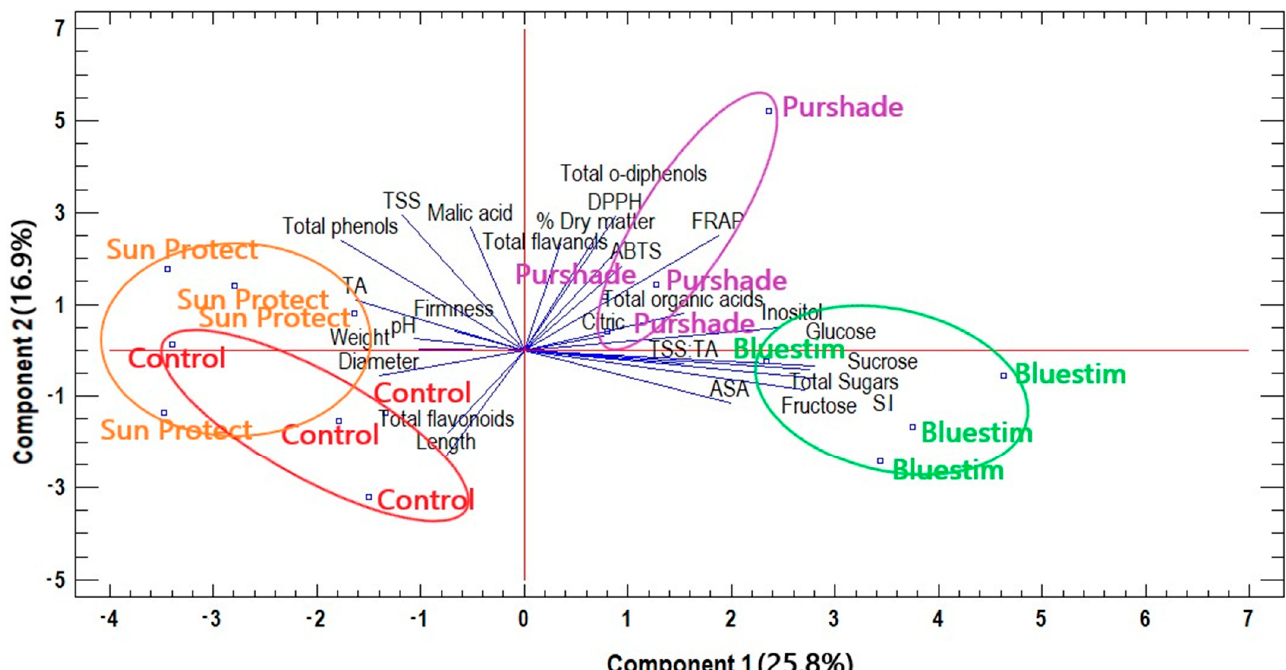
Figure 5. Biplot of the principal components analysis of data collected after storage at 0.5 °C for 107 days. Abbreviations: ABTS, 2,2-azino-bis (3-ethylbenzothiazoline-6-sulfonic acid); ASA, ascorbic acid; DPPH, 2,2-diphenyl-1-picrylhydrazyl; FRAP, Ferric Reducing Antioxidant Power; SI, sweetness index; TA, titratable acidity; TSS, total soluble solids; TSS:TA, the ratio of total soluble solids: titratable acidity.